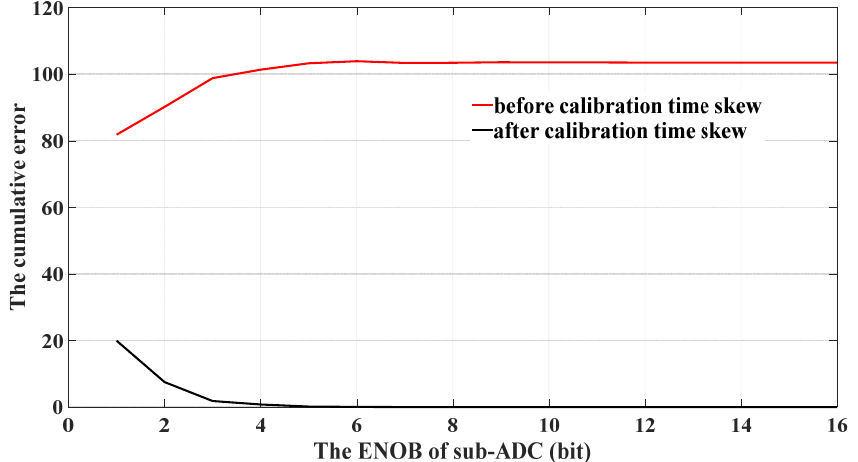
Figure 14. The cumulative errors under different ENOB of the sub ‐ ADC in the proposed technique.